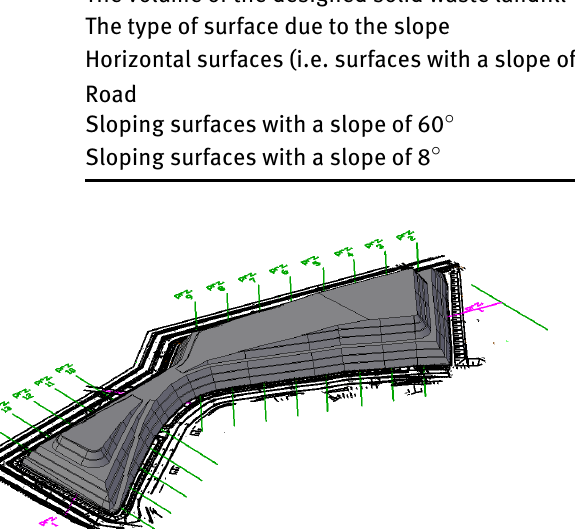
Table 1: Volume and area of slopes (sloping) and shelves (horizontal) obtained in the study The parameters of the designed solid waste landfill